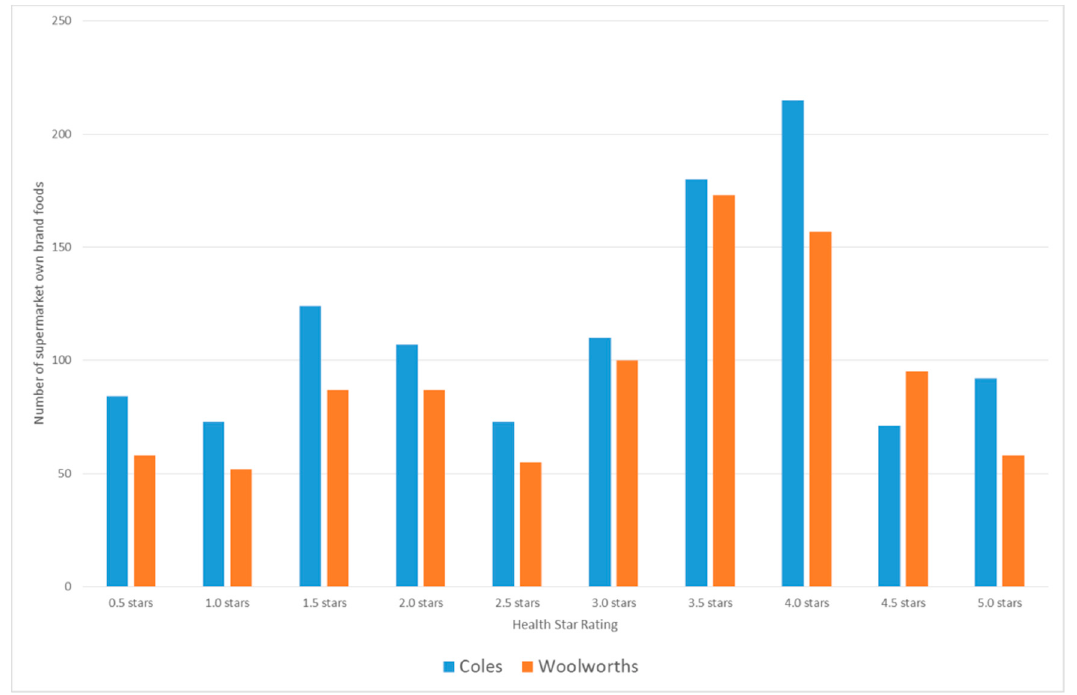
Figure 1. Frequency of Health Star Rating scores for supermarket own brand foods.